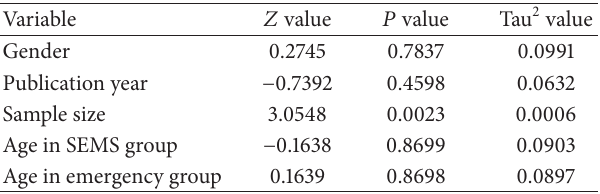
Table 5: Metaregression analysis of primary anastomotic rate of semielective surgery after SEMS installation versus emergency